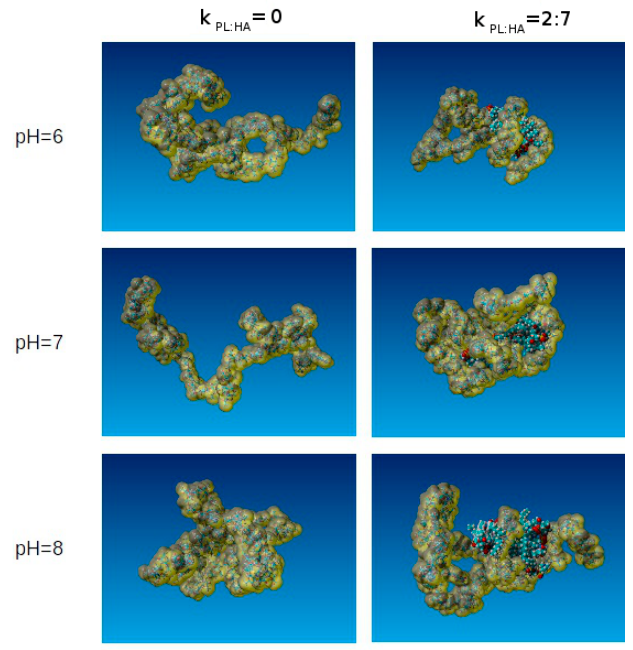
Figure 11. Visualization of solvent accessible surfaces as a function of pH and DPPC concentration. Red depicts oxygen; cyan, carbon; white, hydrogen; blue, nitrogen; and yellow, phosphorus.